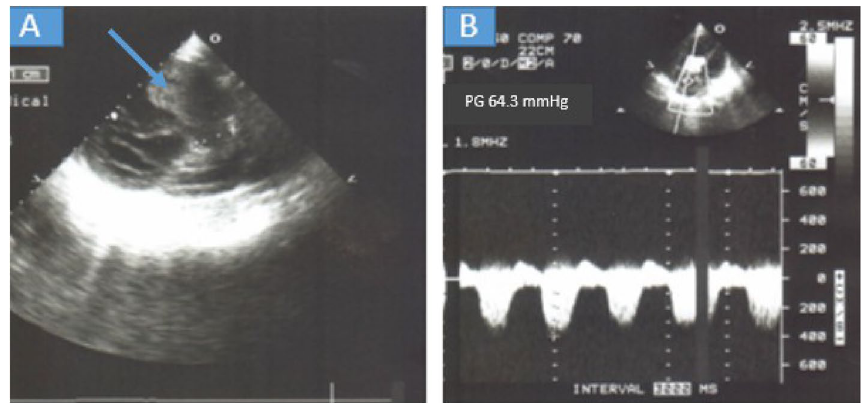
Fig. 1 A Two-dimensional transthoracic echocardiogram (TTE), parasternal long-axis view showing a large mass in the right ventricle. B Two-dimensional TTE, apical view, with continuous wave Doppler showing severe tricuspid regurgitation with a pressure gradient of 64.3 mmHg across the tricuspid